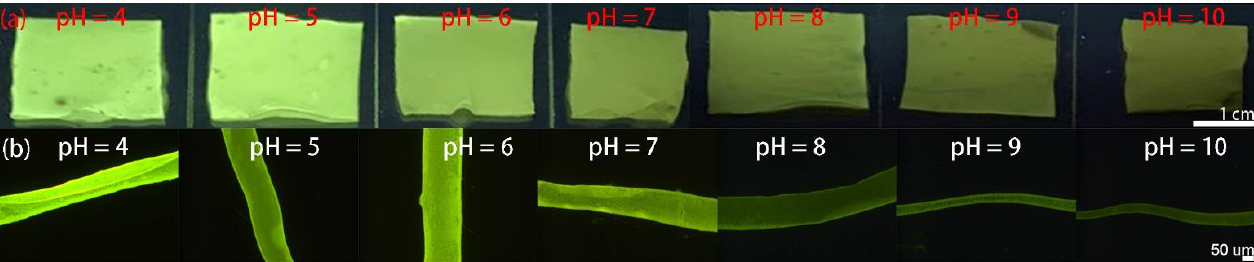
Figure 5. ( a ) The surface luminescence and ( b ) single nanofiber-inverted fluorescence microscope images of NFM2 at different pH levels.